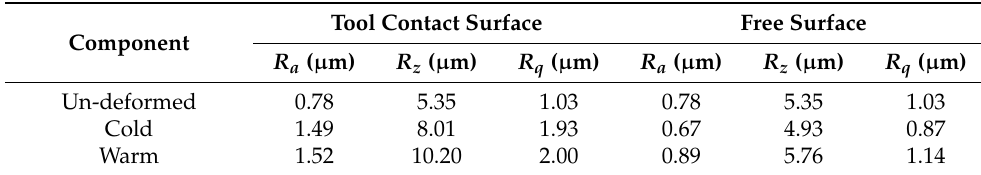
Table 13. Two-dimensional surface roughness of both surfaces of the cone, measured by surface roughness tester.